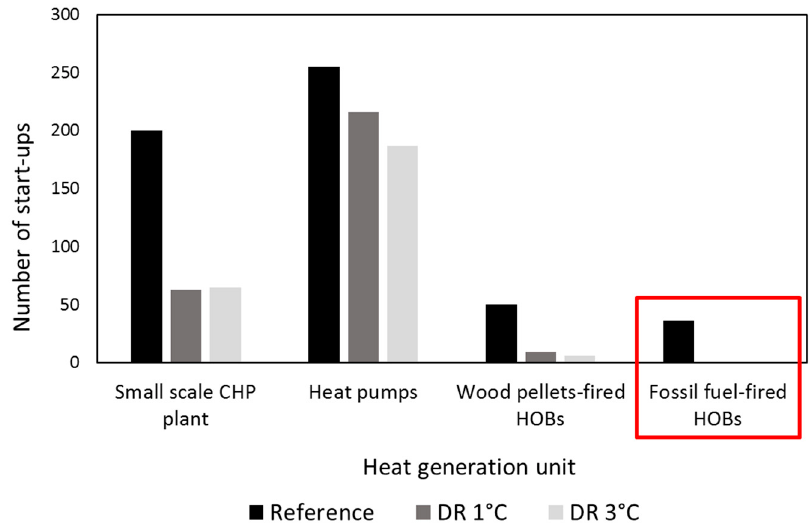
Figure 7. Numbers of start-ups for the heat generation units in the DH system of the City of Gothenburg, as obtained from the modeling for 2012 for the Reference, DR 1 °C, and DR 3 °C scenarios.